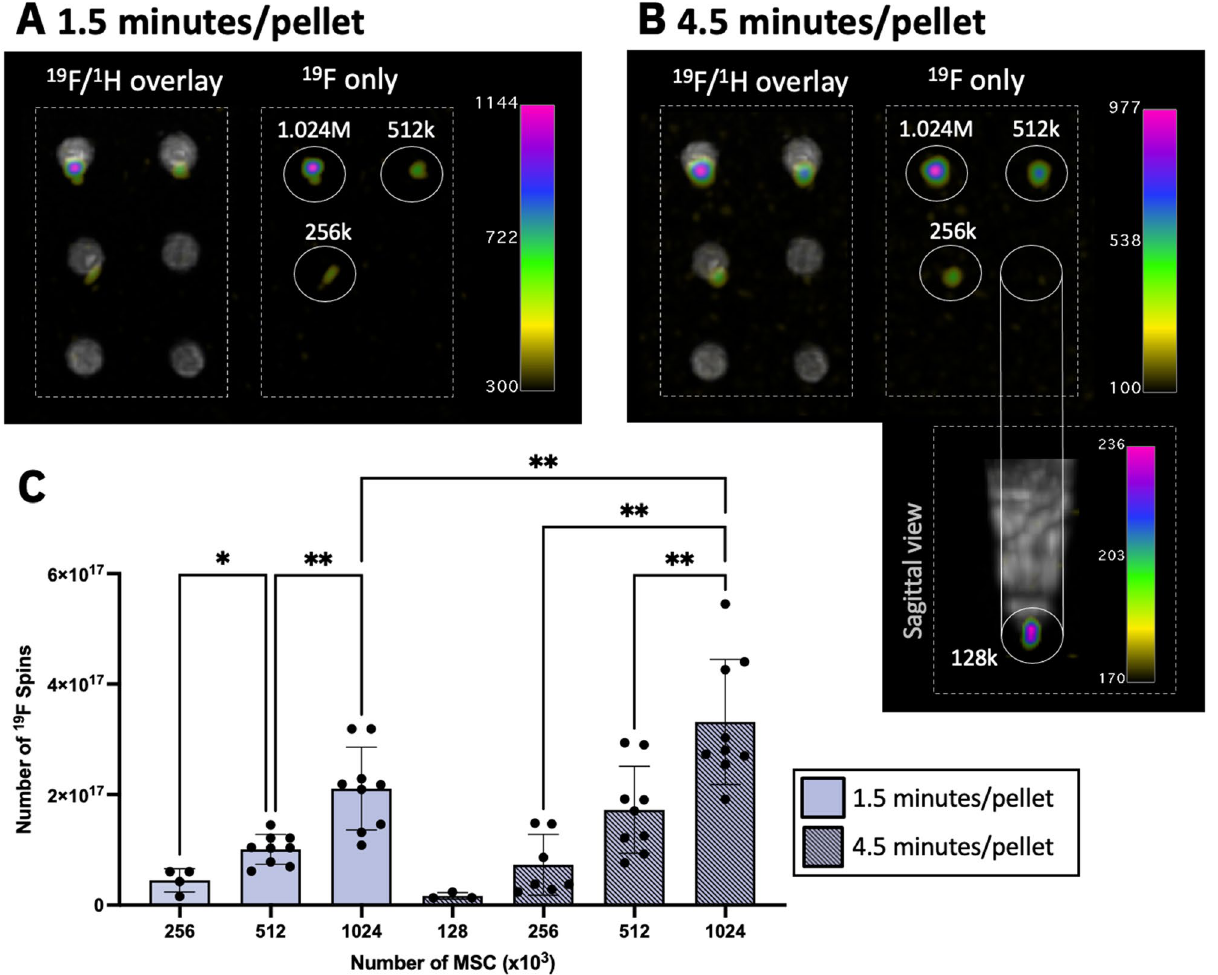
Figure 4. 19 F MRI detection of PFPE-labeled MSC. ( A ) 19 F images of six samples with various cell numbers (M = 10 6 , k = 10 3 ) imaged 1.5 min/pellet. As few as 256 × 10 3 cells (9.01 × 10 16 19 F atoms) could be detected with SNR > 5. ( B ) With longer imaging time (4.5 min/pellet), the detection of 128 × 10 3 cells (4.51 × 10 16 19 F atoms) was possible with SNR > 5. ( C ) Quantification revealed significant differences in 19 F signal between different with longer imaging times ( P <